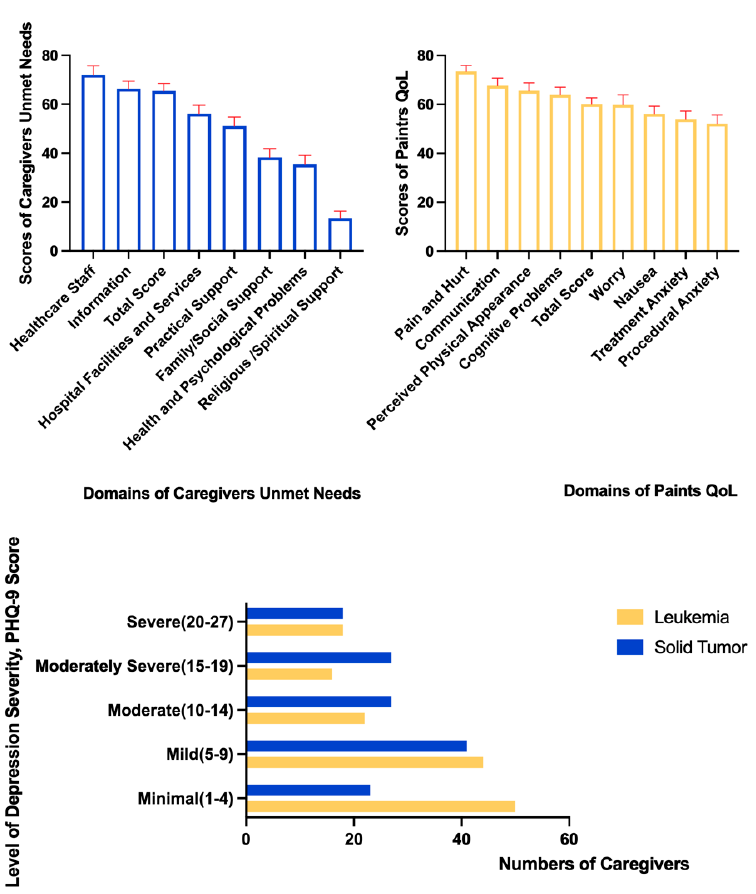
Figure 3. Descriptive statistics for the unmet needs and depression of caregivers and the QoL of care recipients (N = 286).